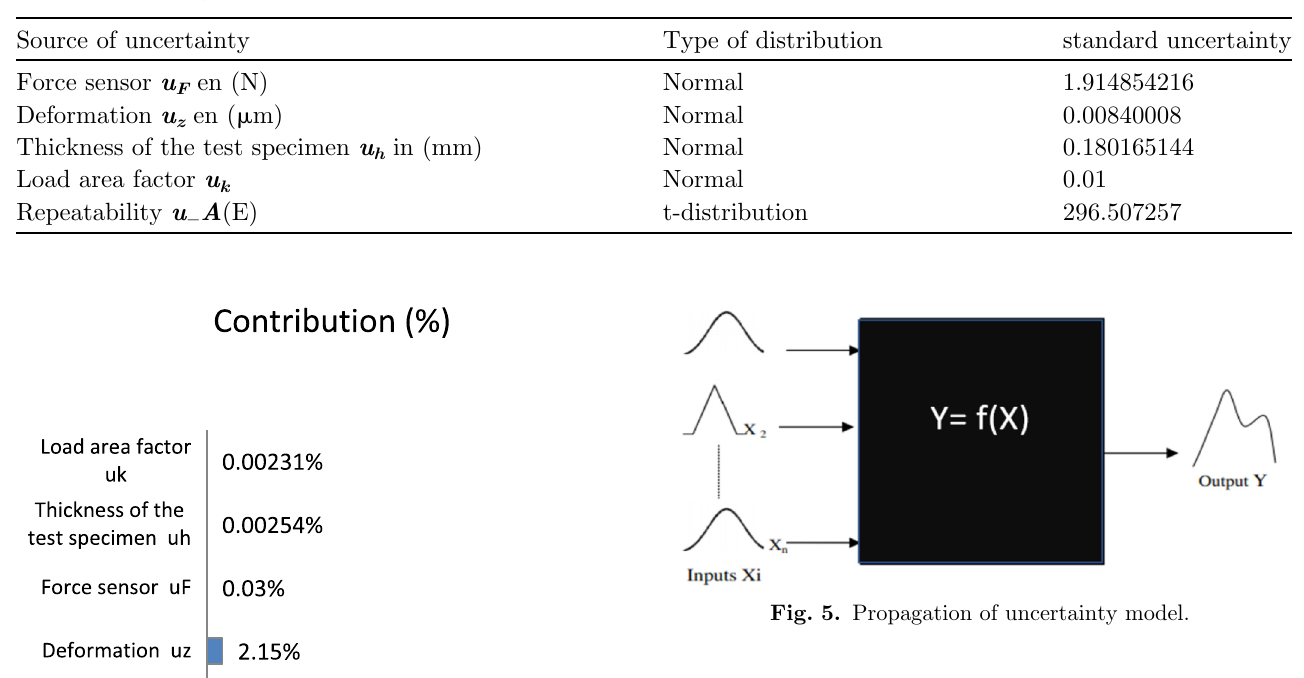
Table 4. Density of distributions for the input variables.